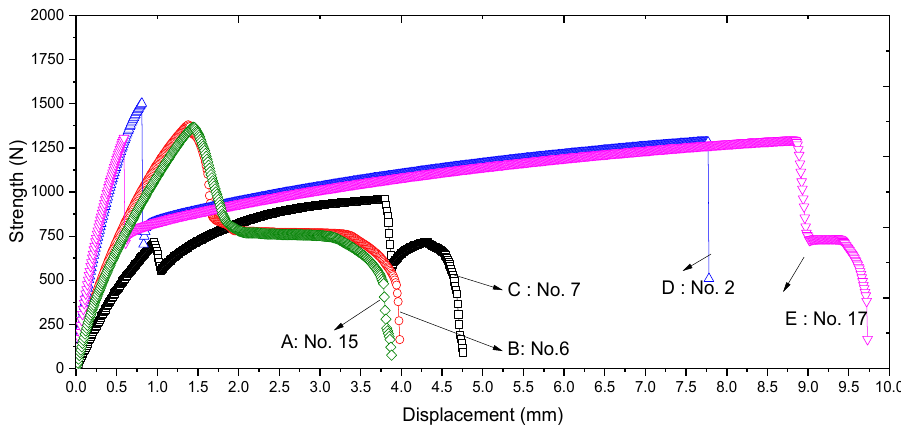
Figure 10. Five kinds of displacement–strength curves represented by multi-layer ultrasonic welding in a one-step shear strength test.